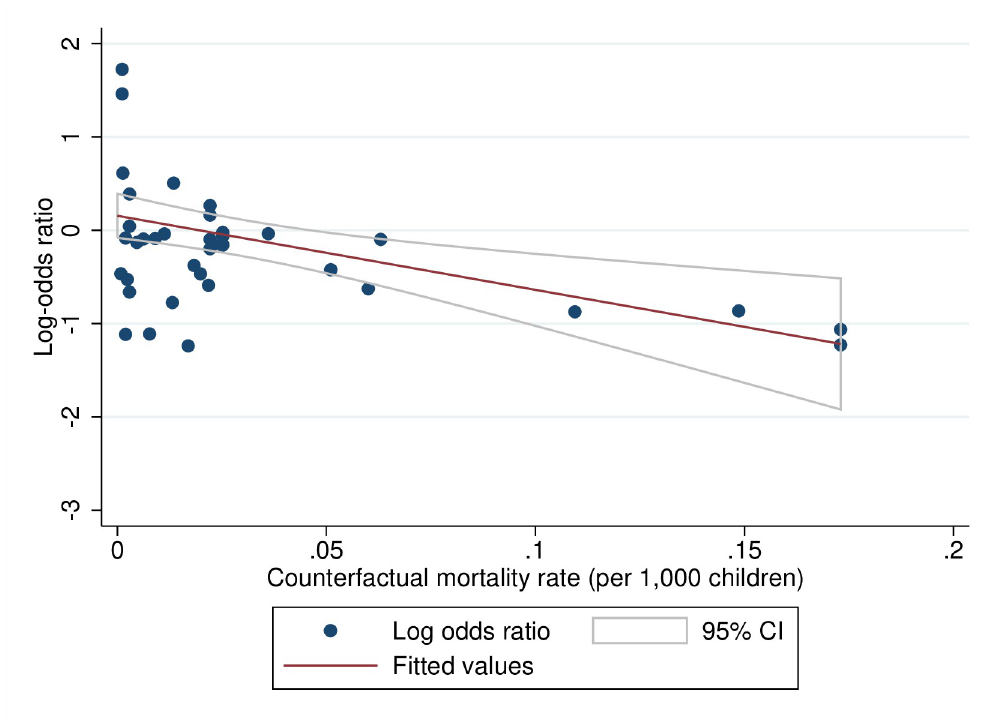
Fig 10. Meta-regression plot of all-cause mortality in childhood against